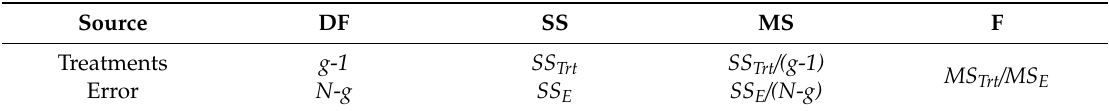
Table 3. General layout of the ANOVA table.